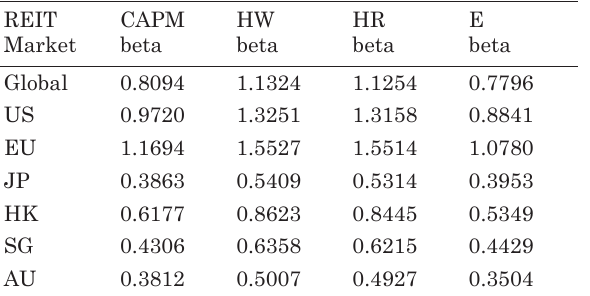
Table 6. The mean of time-varying beta (rolling-beta) REIT Market